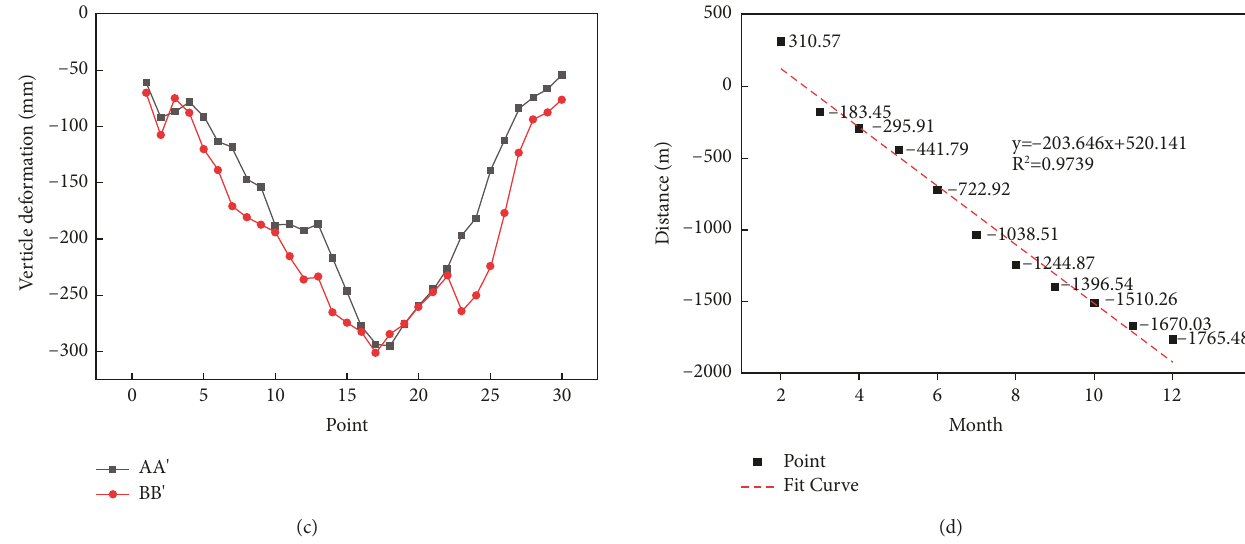
Figure 13: Subsidence analysis map of Xianhe town. (a) Enlarged plot of settlement rate. AA ′ and BB ′ are profile lines, the black and yellow lines are Shugang expressway, and the areas with subsidence rates greater than − 300mm/a, − 250mm/a, and − 150mm/a are denoted by red, green, and blue vectors, respectively. (b) The vector denotes the range of cumulative subsidence greater than 20mm (with reference to 10 January 2018). The vectors of brown, dark green, purple, and light green are the cumulative subsidence in February 15, April 10, August 14, and December 24. (c) Profile maps based on AA ′ and BB ′ . (d) The fitted line of the distance between the subsidence boundary and the Shugang expressway and month.